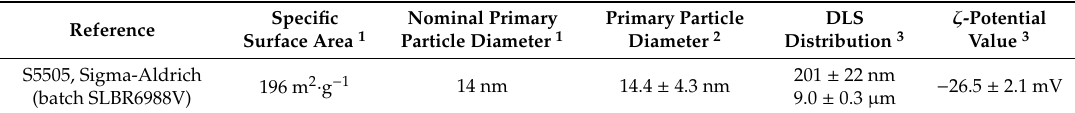
Figure 2. Typical TEM images of unstained fumed silica nanoparticles suspended in water. Aqueous suspension of nanoparticles was deposited onto a formvar / carbon coated copper grid and observed using a JEOL 1400 TEM instrument operating at 120 kV. Analysis of recorded images was performed using ImageJ 1.52 software. Table 1. Characteristics of aSNP.